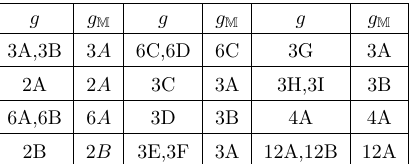
Table 5 . Generalized bilinear relation for 3 (cid:1) Fi 0